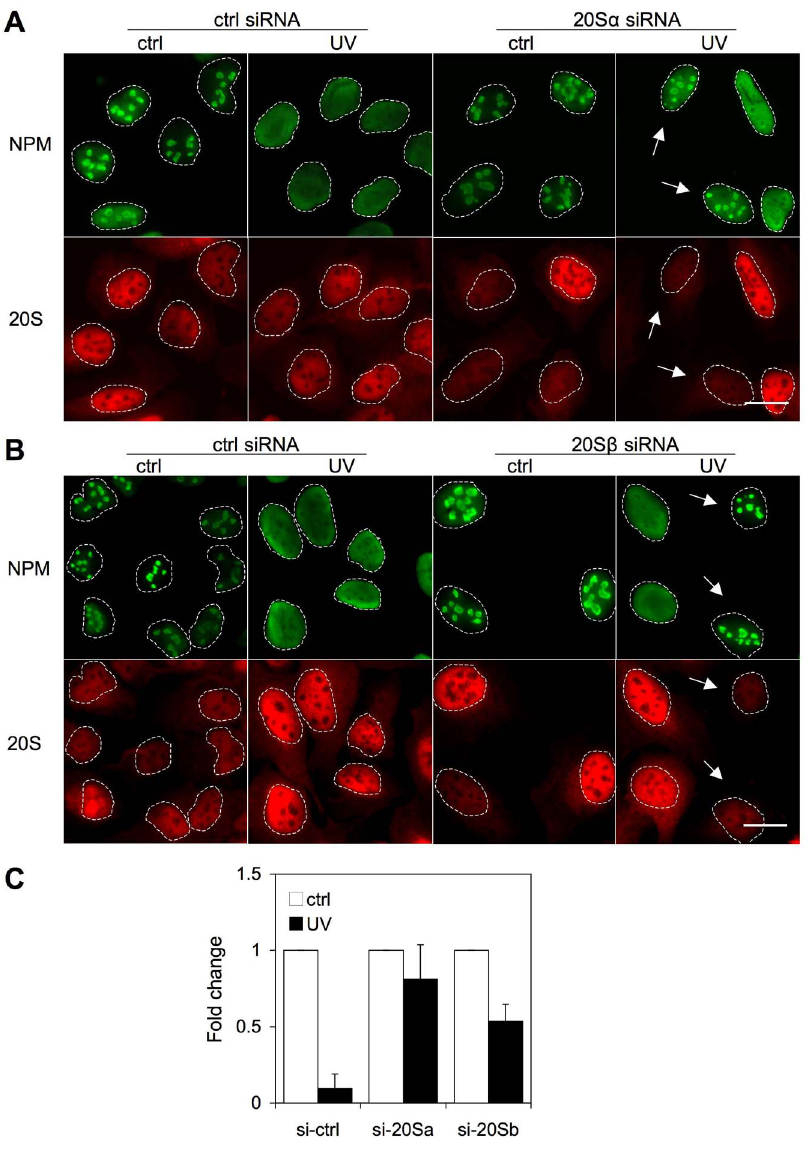
Figure 7. Inhibition of expression of 20S proteasome prevents NPM relocalization after UV radiation. U2OS cells were transfected with specific siRNAs against 20S a ( A ) and 20S b ( B ) subunits and the cells were incubated for 72 hours. The cells were then treated with UV radiation (35 J/ m 2 ) for 3 hours or left untreated. Cells were fixed and stained for NPM and 20S. Arrows indicate 20S silenced cells. C Nucleolar areas were quantified from two independent experiments. Scale bars 20 m